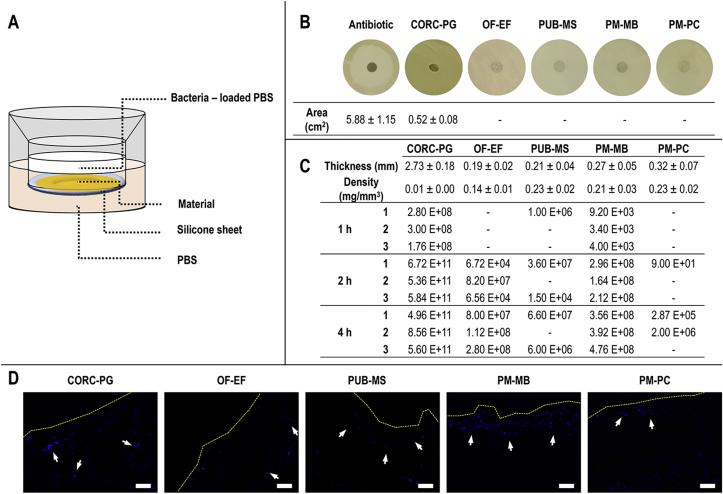
Bacterial penetration assay was carried out using an in-house trans-well system (A). Among the groups, only the CORC-PG showed bacteria growth inhibition (B). The CORC-PG showed the highest CFU number at all time points (C). Immunohistochemistry analysis of transverse sections after 24 h of bacterial incubation revealed bacterial colonization at the inner layers of the CORC-PG, OF-EF, and PUB-MS products (D). Area, thickness, and density data are expressed as average ± standard deviation (n = 4 for growth inhibition assay, n = 3 for thickness and density). Manual count of CFUs is represented with the value of each replicate; ‘-’ indicates the absence of colonies. Scale bars 50 μm.